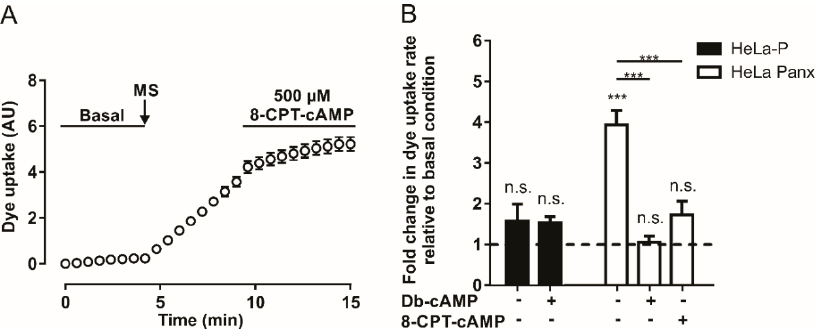
Figure 2. The cAMP analogs reduce mechanical stretch-induced activity of Panx1 channels. ( A ) Temporary course of DAPI uptake in HeLa-Panx1 cells at basal condition, after mechanical stretch (MS, arrow) and during treatment with 500 µM 8-CPT-cAMP. ( B ) Normalized dye uptake rate in HeLa-P (black bars) and HeLa Panx1 (white bars) cells subjected to MS and subsequently treated with Db-cAMP or 8-CPT-cAMP. Statistical analysis in B was performed between each experimental group (connecting lines) and comparing each group with baseline (symbols above each bar). Note: *** p < 0.001; n.s., not significant. Each value in B corresponds to the average ± standard error of a total of four to ten independent